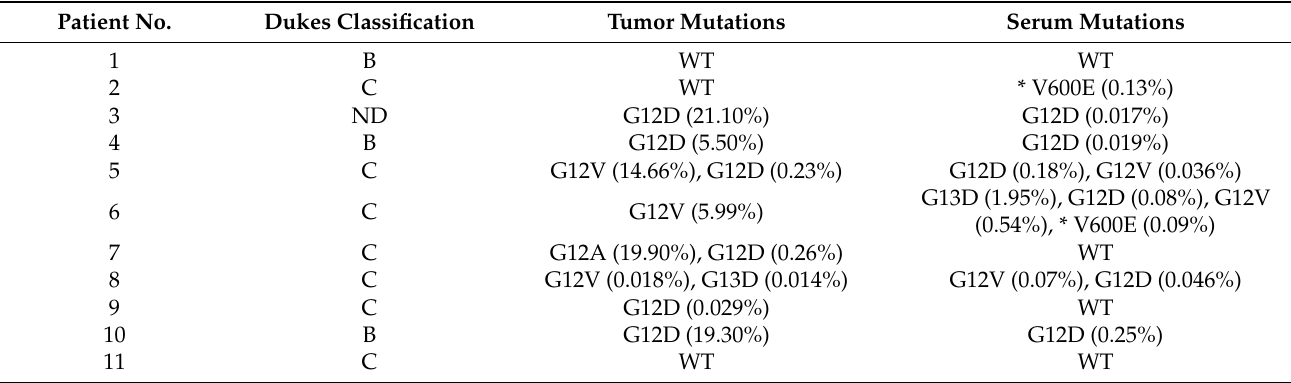
Table 1. Overview of colorectal cancer patients’ samples used in tumor/serum matching study: classification of tumor samples according to Dukes, detected KRAS and BRAF V600E (*) mutations and their fractional abundance from tumor DNA, and cell-free DNA isolated from serum drawn just before surgery. ND—not determined, WT—wild type. Patient No.